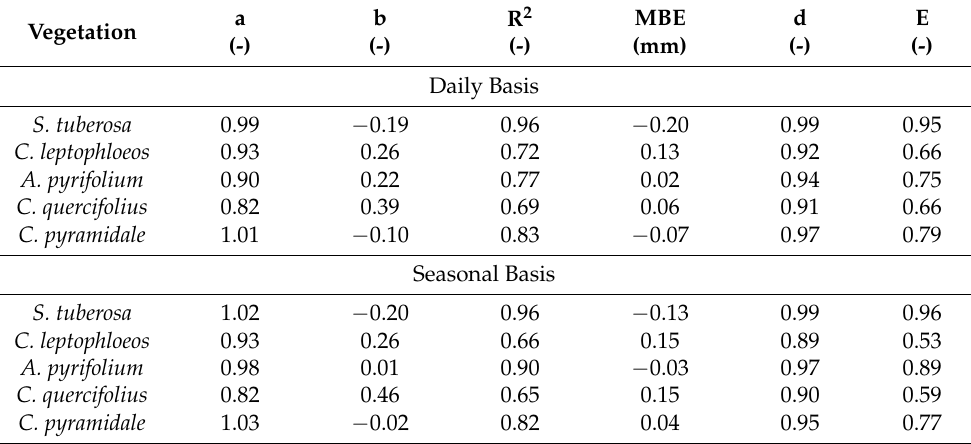
Table 6. Summary statistics of interception values predicted by the sparse Gash model parametrized on daily and seasonal bases applied to Caatinga species on storm-based rainfall analysis.